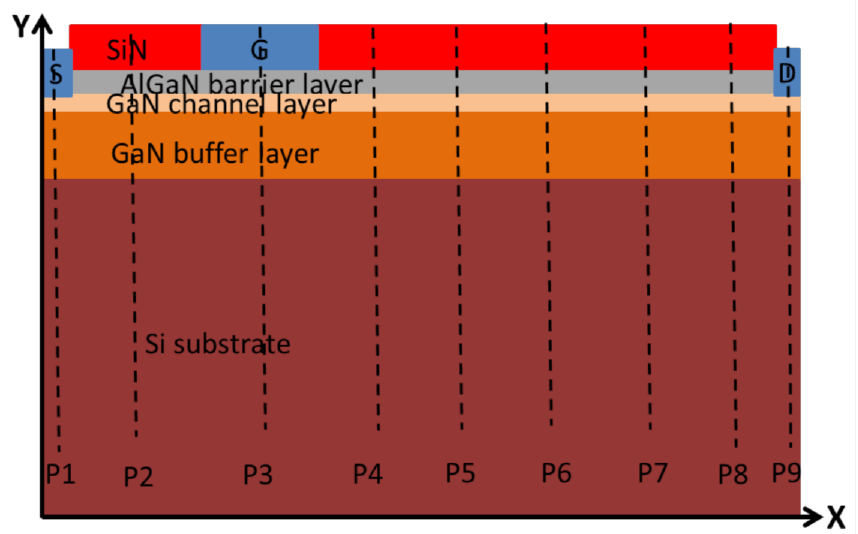
Figure 7. The cross-section of AlGaN/GaN HEMT with different heavy-ion track positions.